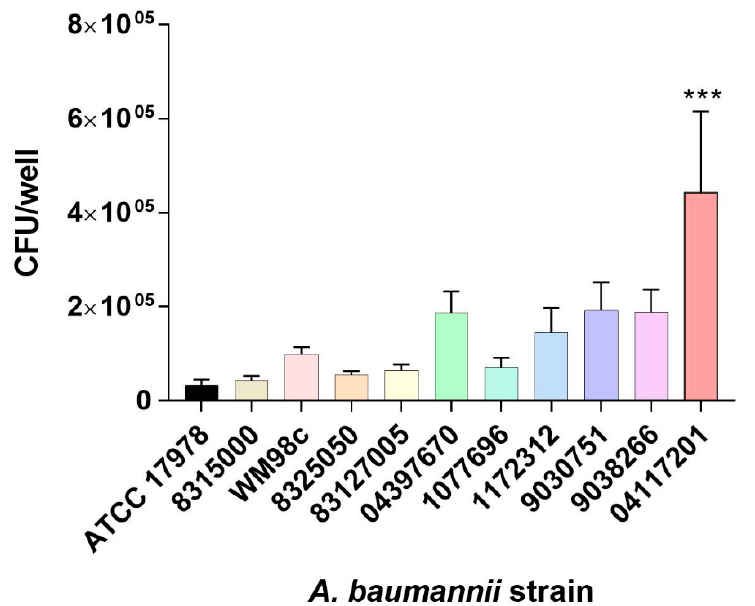
Figure 1. Cell adherence capacity of A. baumannii clinical strains to A549 pneumocytes. The CFU/well values of 11 A. baumannii strains were examined after exposure to A549 cells. Bars indicate the standard error of three separate experiments. Assessments of skewness, kurtosis and the Shapiro–Wilk normality test were undertaken. *** represents a p -value of < 0.001 as determined by an analysis of variance test, between ATCC 17978 and the clinical isolate. Table 1. Antimicrobial resistance profiles of Acinetobacter baumannii clinical strains.